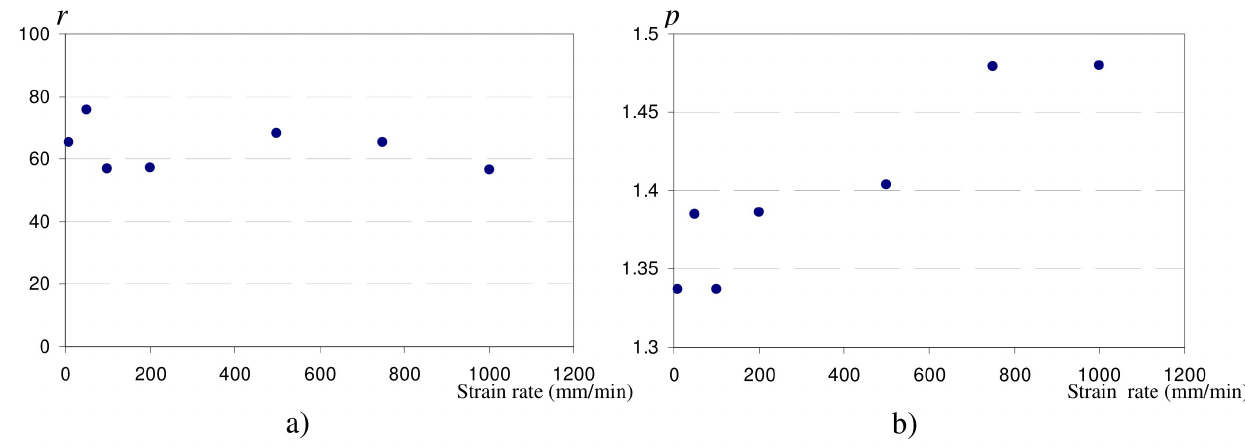
Figure 6. (a) Pre-factor r and (b) exponent p vs. strain rate.